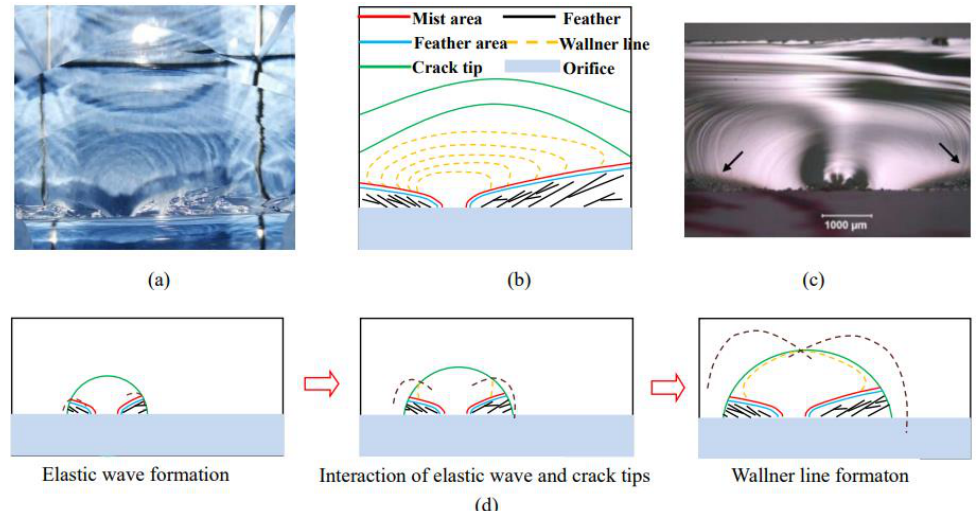
Figure 9. Dynamic crack bifurcation and the characteristic of the Wallner line. ( a ) Main crack fractography; ( b ) Main crack characteristics; ( c ) Wallner line in previous studies; ( d ) Wallner line formation.